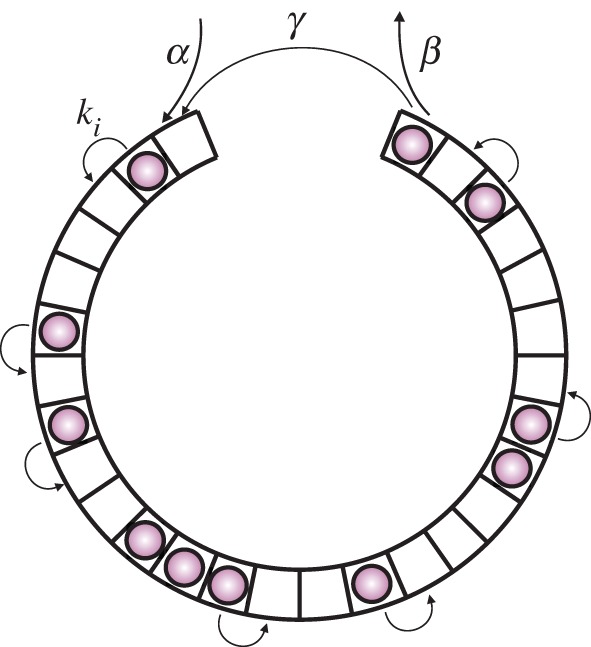
Model of translation with ribosome recycling. Ribosomes are represented by circles and the mRNA is represented by the pseudo-circular lattice. Ribosomes bind the mRNA with a rate α, and hop from site i to site i + 1 with rate ki. If the first site of the lattice is unoccupied, a terminating ribosome can move into this site with rate γ and restart translation along the mRNA. It remains the case that the terminating ribosome can also detach from the mRNA with rate β and re-enter the reservoir. As such, there are two potential means of ribosomes exiting the mRNA. (Online version in colour.)